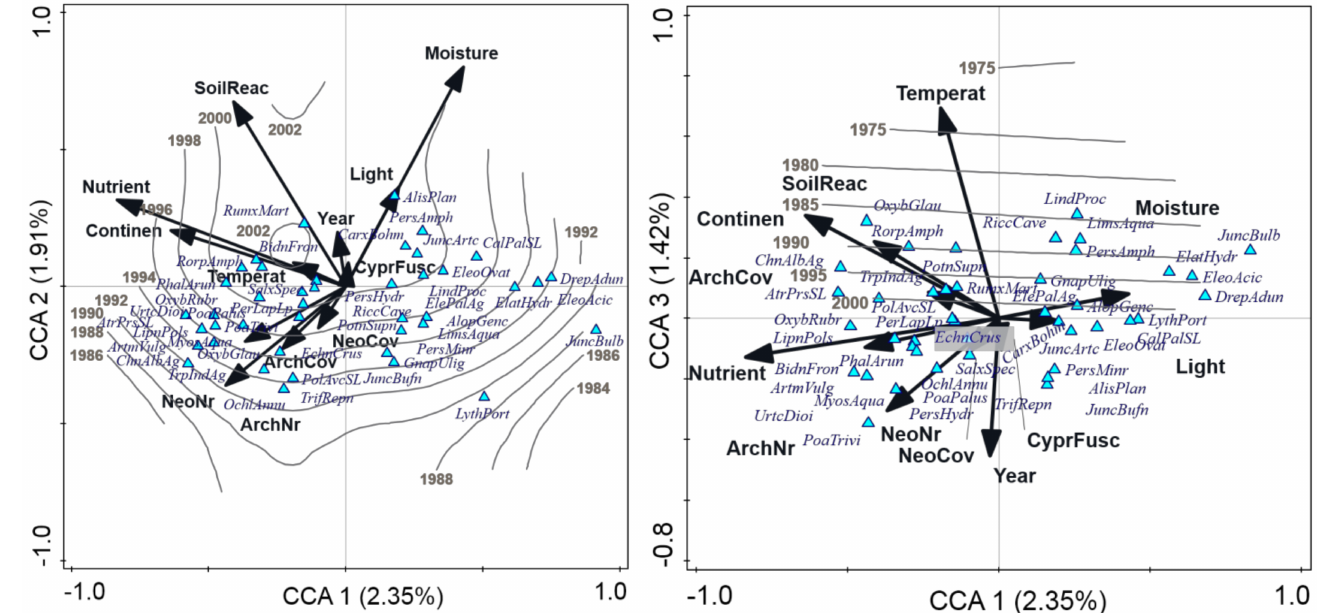
Figure 1. Canonical correspondence analysis (CCA) ordination diagram of species and independent variables supplemented with contour lines representing the year. Only 42 species with the highest contribution on the horizontal axis are